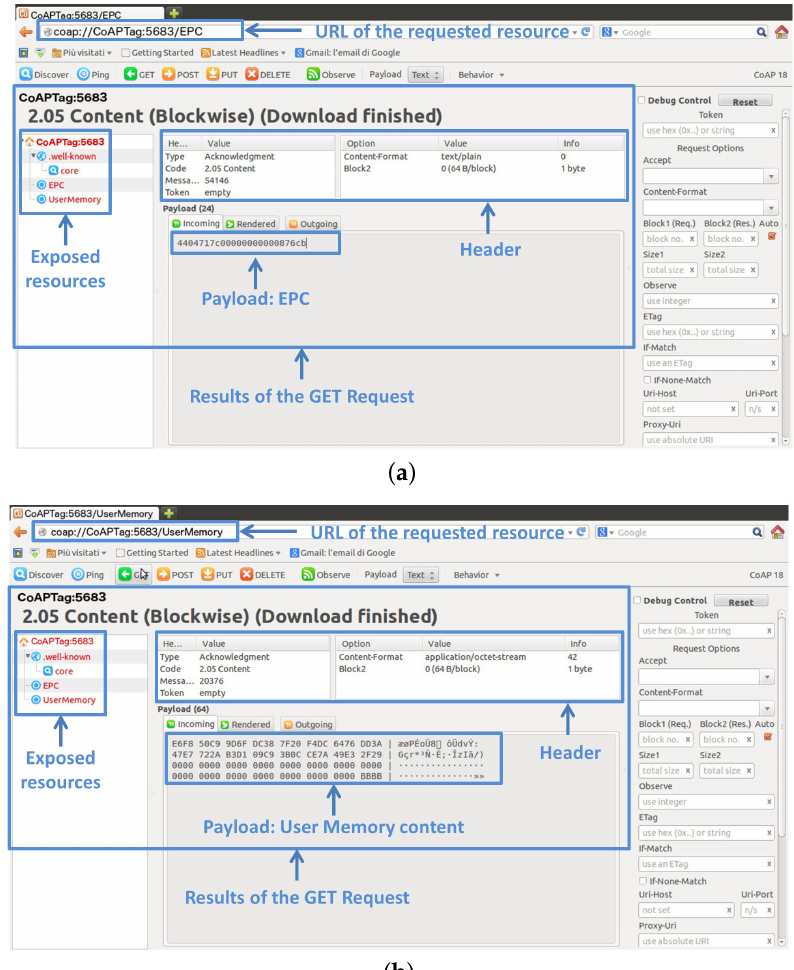
Figure 7. Screenshots of Copper showing the result of a GET request to: ( a ) the EPC code; ( b ) the user